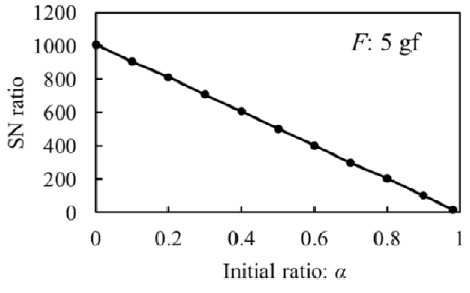
Figure 6. Initial ratio vs. SN ratio at load weight of 5 gf.